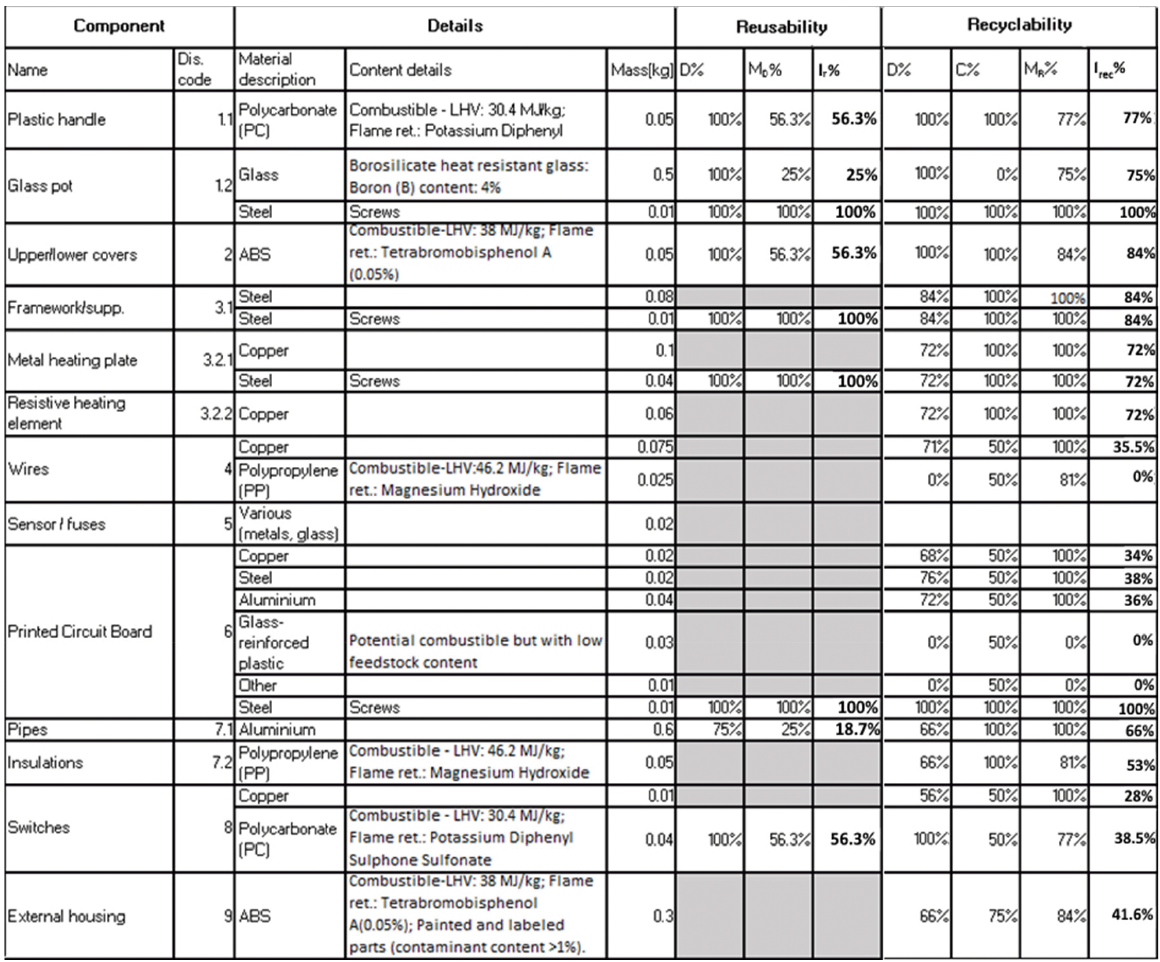
Component Cost (€/pc)